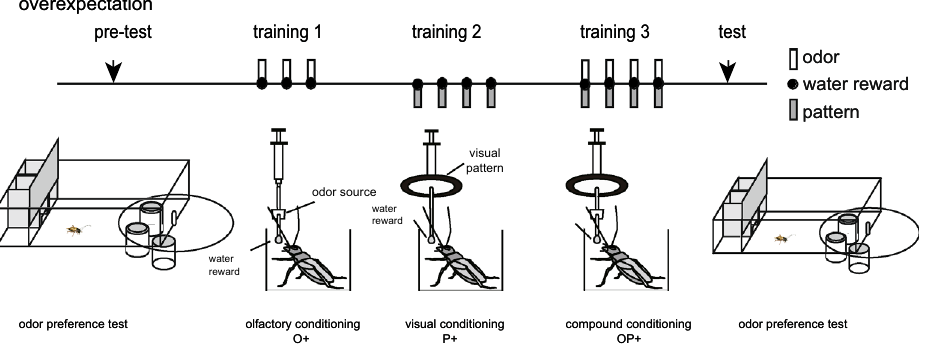
Figure 1. Experimental procedure for overexpectation in olfactory conditioning in crickets. A group of water- deprived crickets, individually placed in a beaker, was subjected to pairings of an odour CS with water US during training 1, to pairings of a visual pattern CS with water US during training 2, and to pairings of an odour and a visual pattern compound with water US during training 3. The relative preference for the conditioned odour and a control odour was tested before and after training in a test